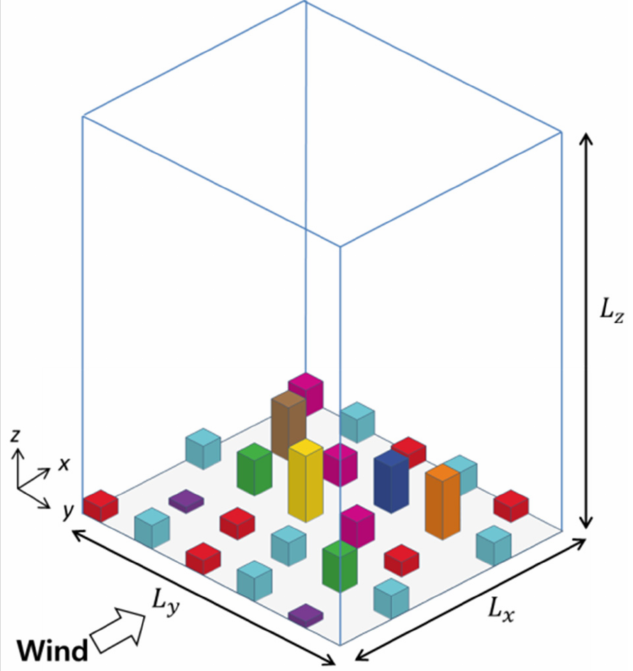
Figure 2. Schematic diagram of the computational domain for λ p = 0.25. [23]. Different colors indicate different building types: B1 (purple), B2 (red), B3 (light blue), B4 (magenta), B5 (green), B6 (dark blue), B7 (brown), B8 (orange), and B9